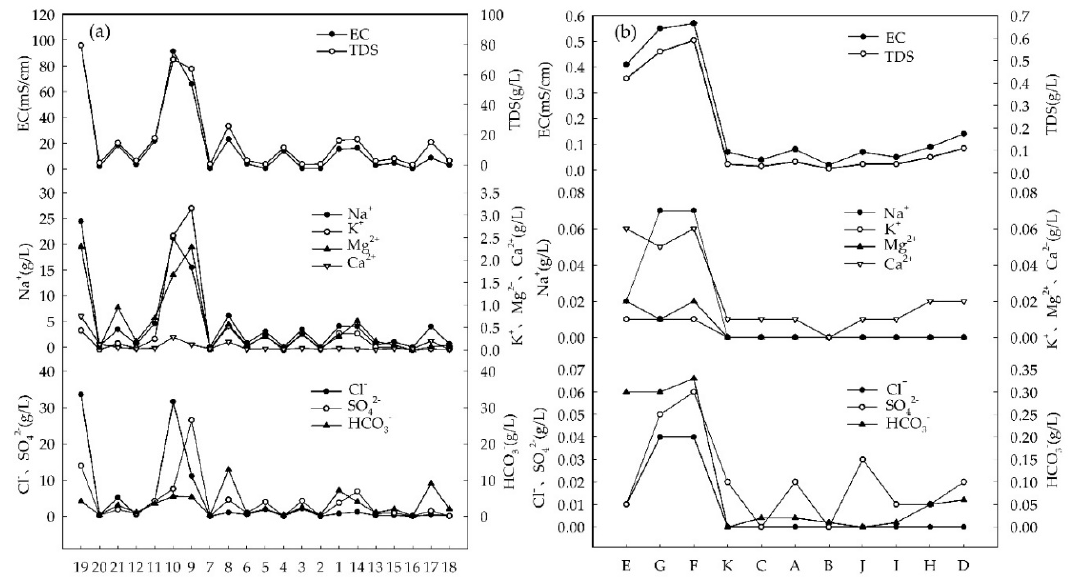
Figure 3. The distribution trends of TDS, Electrical Conductance (EC), and major ion concentration of Tectonic lakes ( a ) and glacial lakes ( b ).